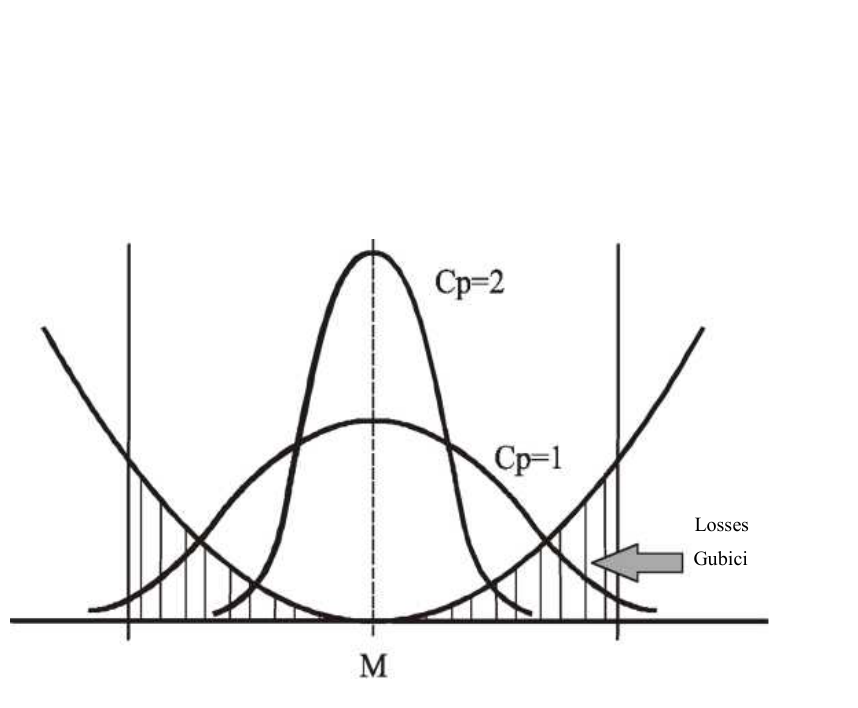
Figure 4 – Dissipation of the process and functions of losses Рис . 4 – Рассеивание процессов и функция